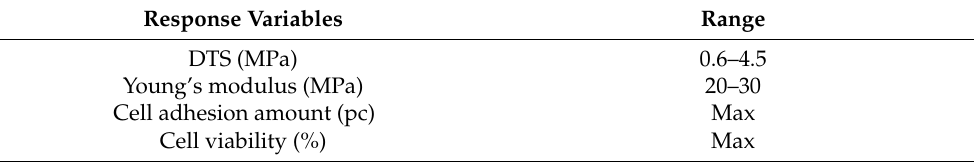
Table 2. Range of response variables.